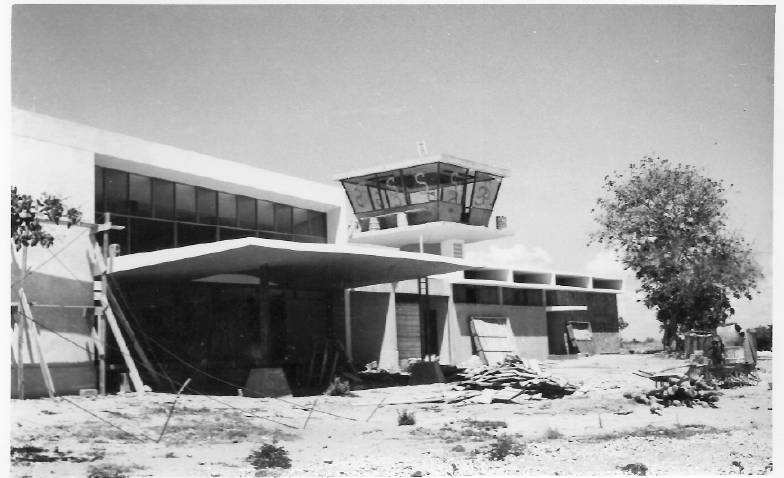
Figure 10. João José Tinoco and Maria Carlota Quintanilha. Pemba Airport under construction. Figure 10. Jo ã o Jos é Tinoco and Maria Carlota Quintanilha. Pemba Airport under